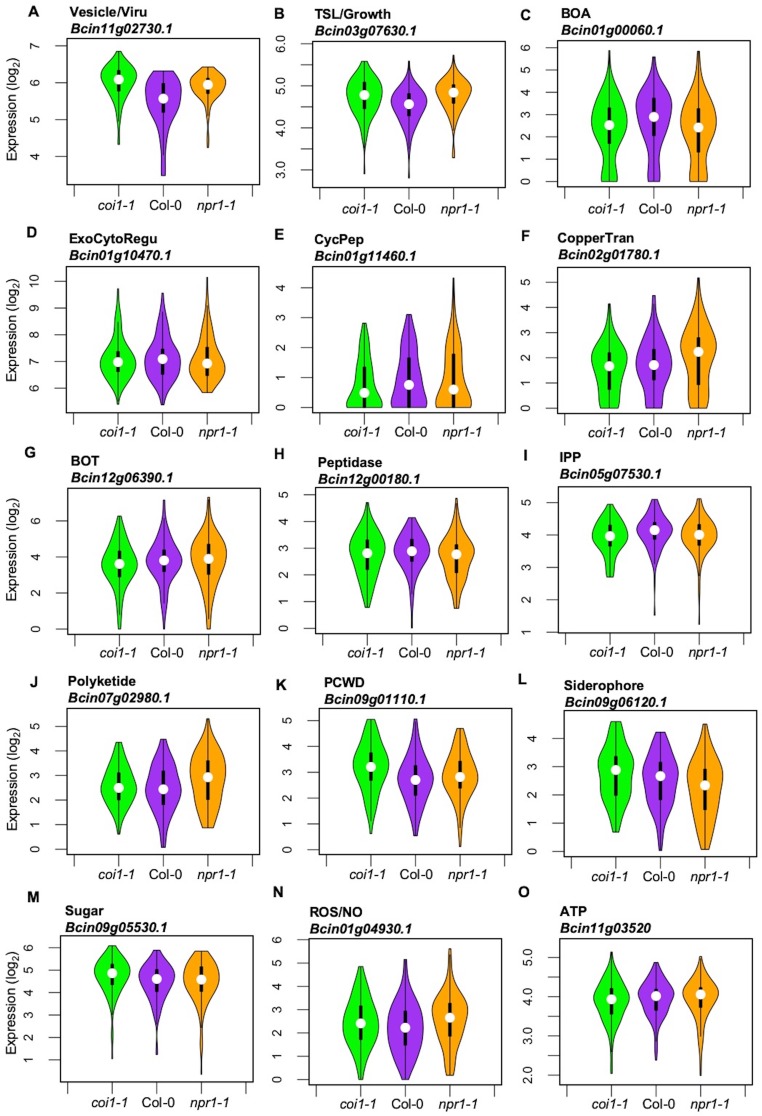
Plasticity in expression profiles of genes identified by B. cinerea gene co-expression networks under varied Arabidopsis immunities.Violin plots of (A) to (O) show the expression profiles of B. cinerea genes in response to variation of Arabidopsis immunity. Genes shown are condensed in B. cinerea gene co-expression networks (GCNs). The model-corrected means (log2) for B. cinerea transcript were used for plotting. The Arabidopsis genotypes, wild-type Col-0 (purple), jasmonate insensitive mutant coi1-1 (green), and salicylic acid mutant npr1-1 (orange), are shown on the x axis.